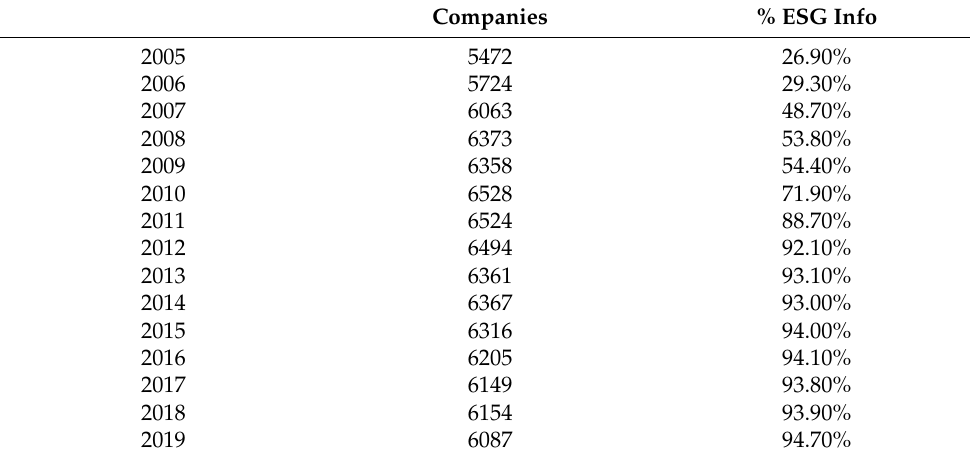
Table 2. The number of companies in the